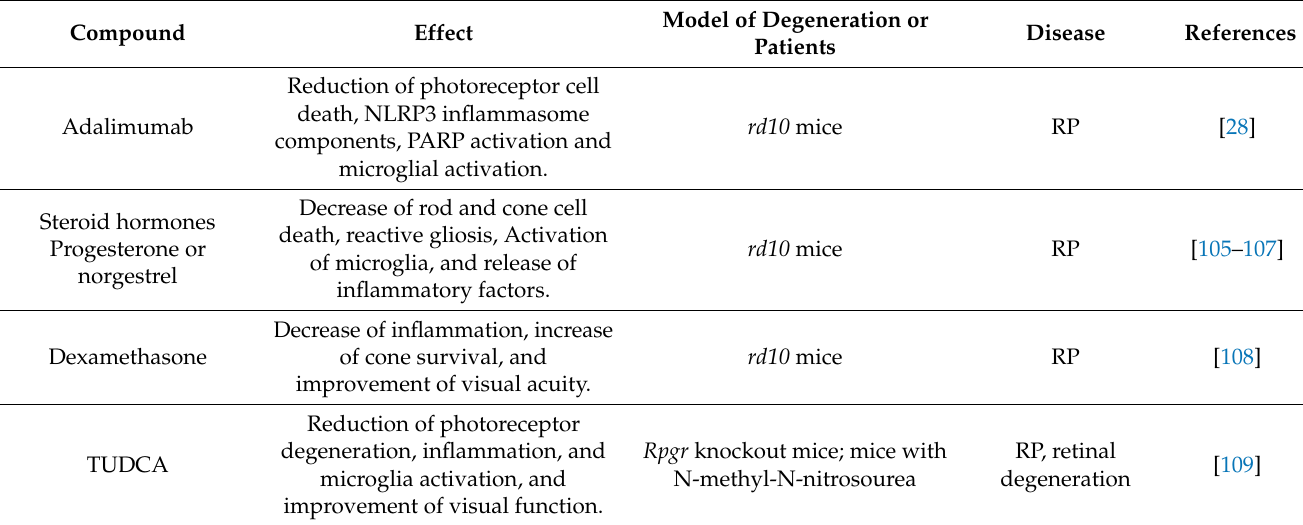
Table 1. Different anti-inflammatory approaches in